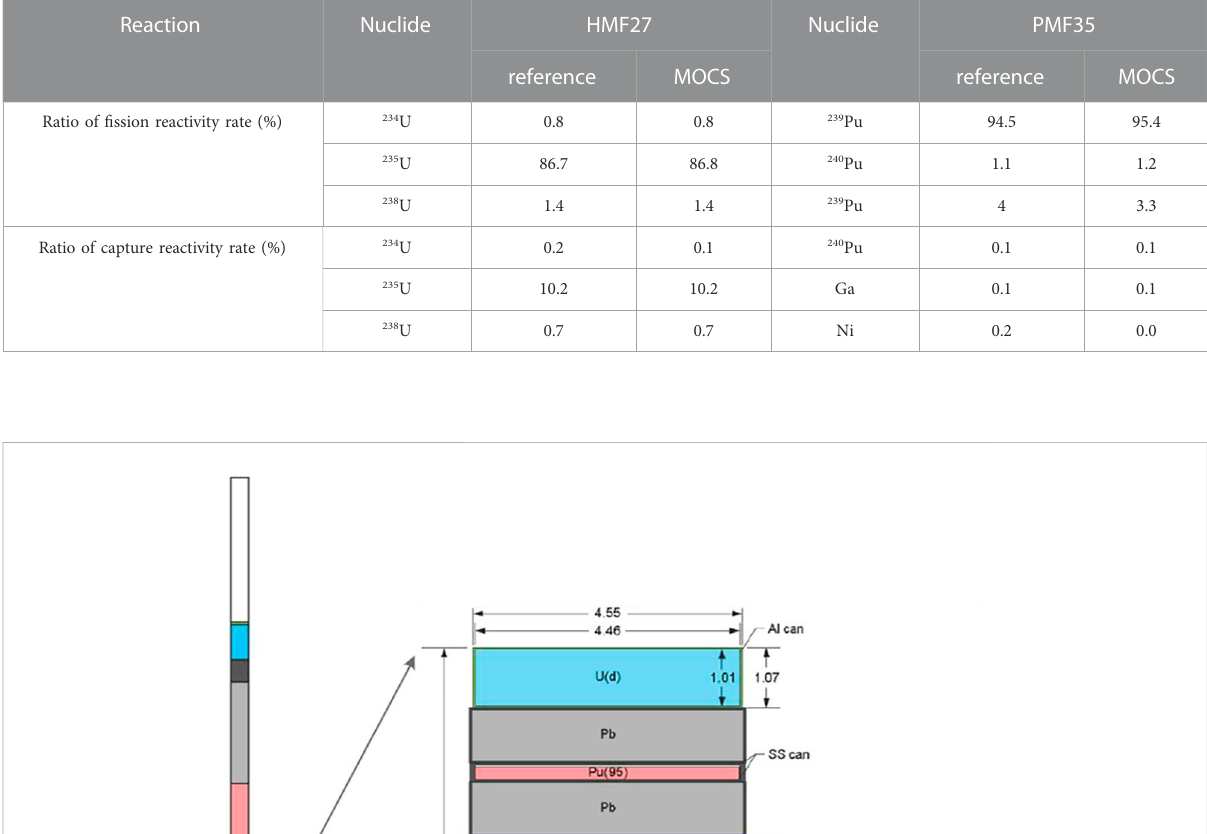
TABLE 4 Results of fi ssion reactivity rate and capture reactivity rate.